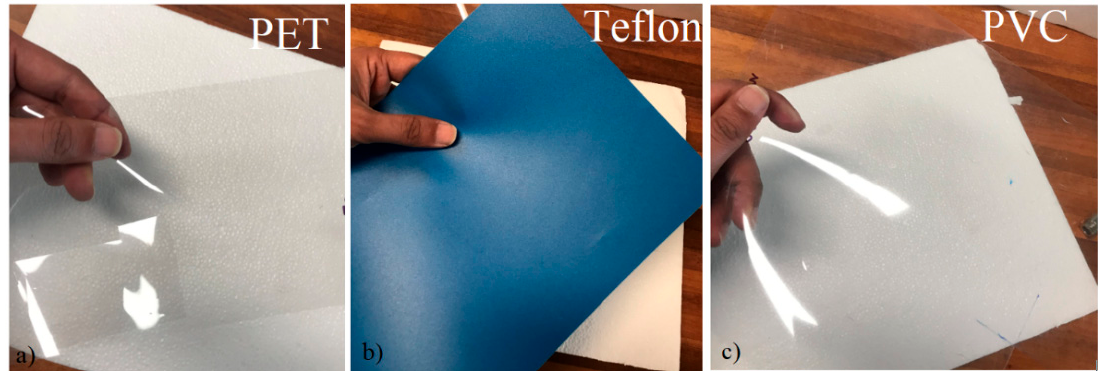
Figure 4. Polymer film sheets: ( a ) transparent PET, ( b ) PTFE Teflon, ( c ) transparent PVC.